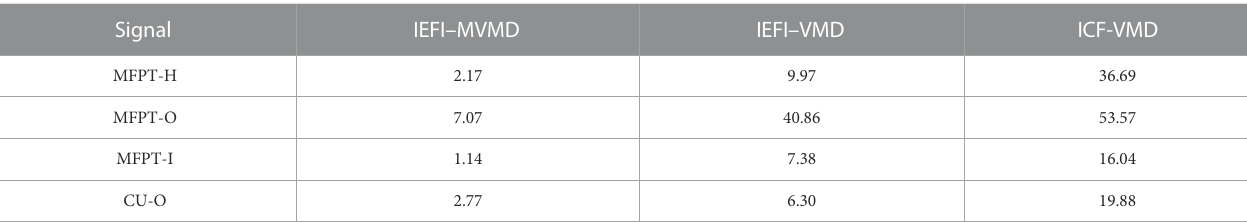
TABLE 1 Calculation time for each signal unit: